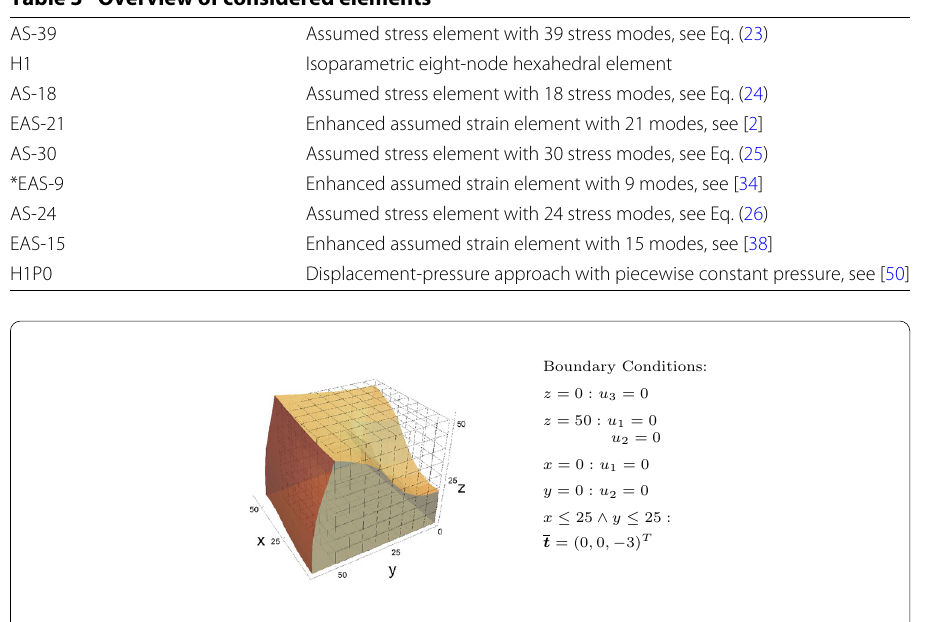
Fig. 1 Inhomogeneous compression Block; geometry, representative mesh, deformed configuration and the boundary